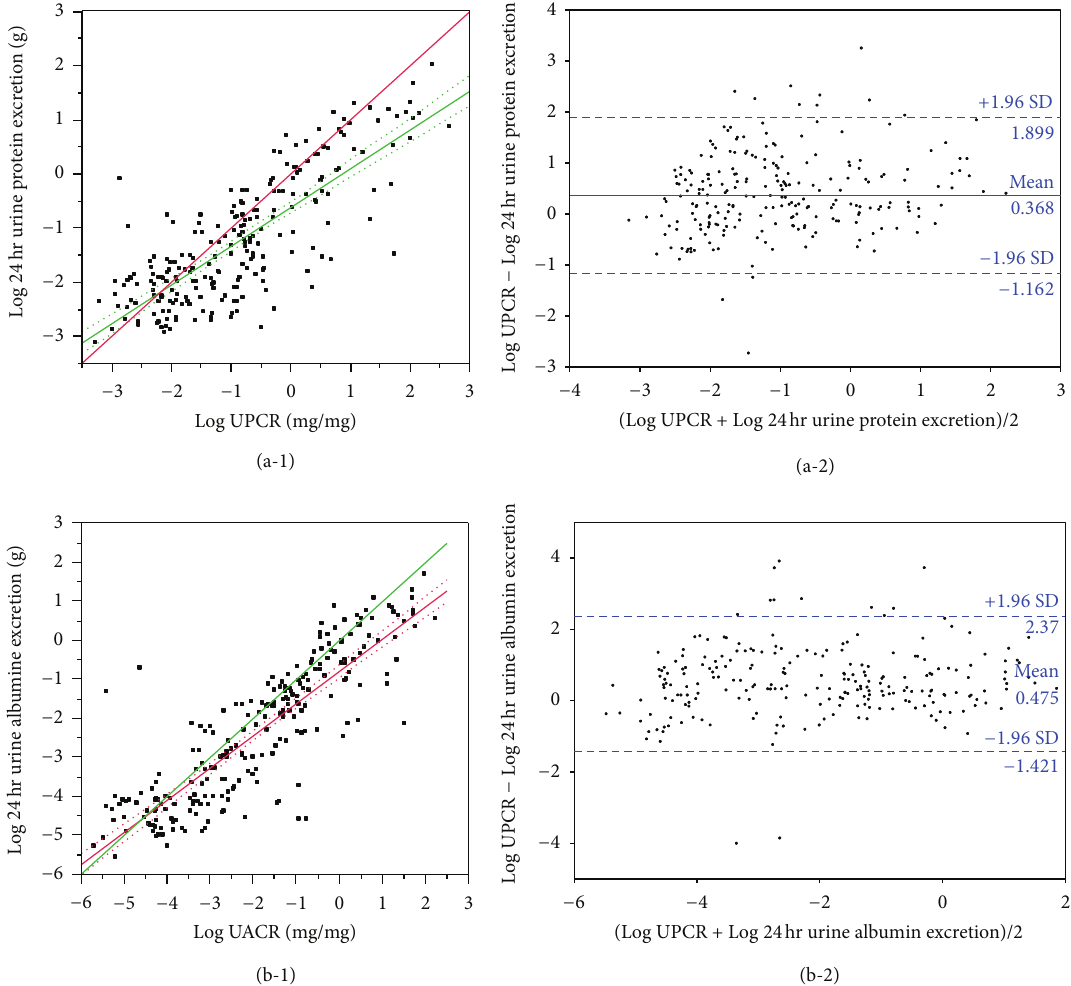
Figure 1: Distribution of urine estimation ratios to 24 hr urine measurements. (a-1) UPCR versus 24 hr urine protein excretion. Correlation 𝑟 = 0.79 , 95% CI 0.74–0.83. Bold line: line of identity; fine line: regression line; dotted lines: 95% CI of the regression line. (a-2) Limits of agreement of Log-transformed UPCR and 24 hr urine protein excretion. (b-1) UACR versus 24 hr urine albumin excretion. Correlation 𝑟 = 0.86 , 95% CI 0.82–0.89. Bold line: line of identity; fine line: regression line; dotted lines: 95% CI of the regression line. (b-2) Limits of agreement of Log-transformed UACR and 24 hr urine albumin